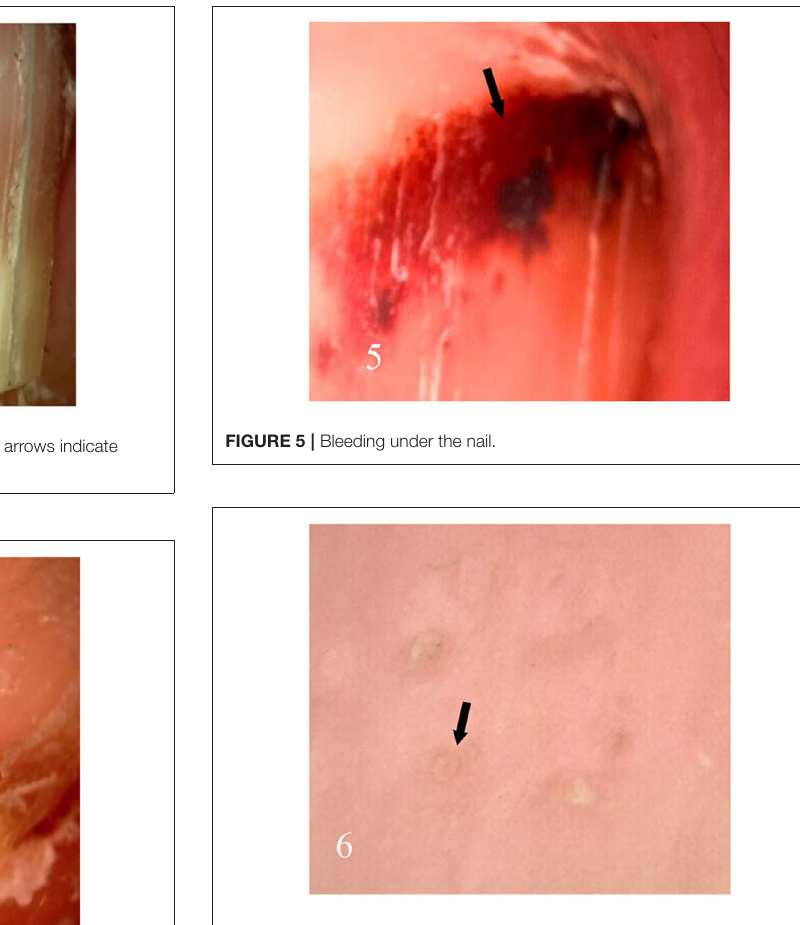
FIGURE 6 | Punctate depression of the nail plate.